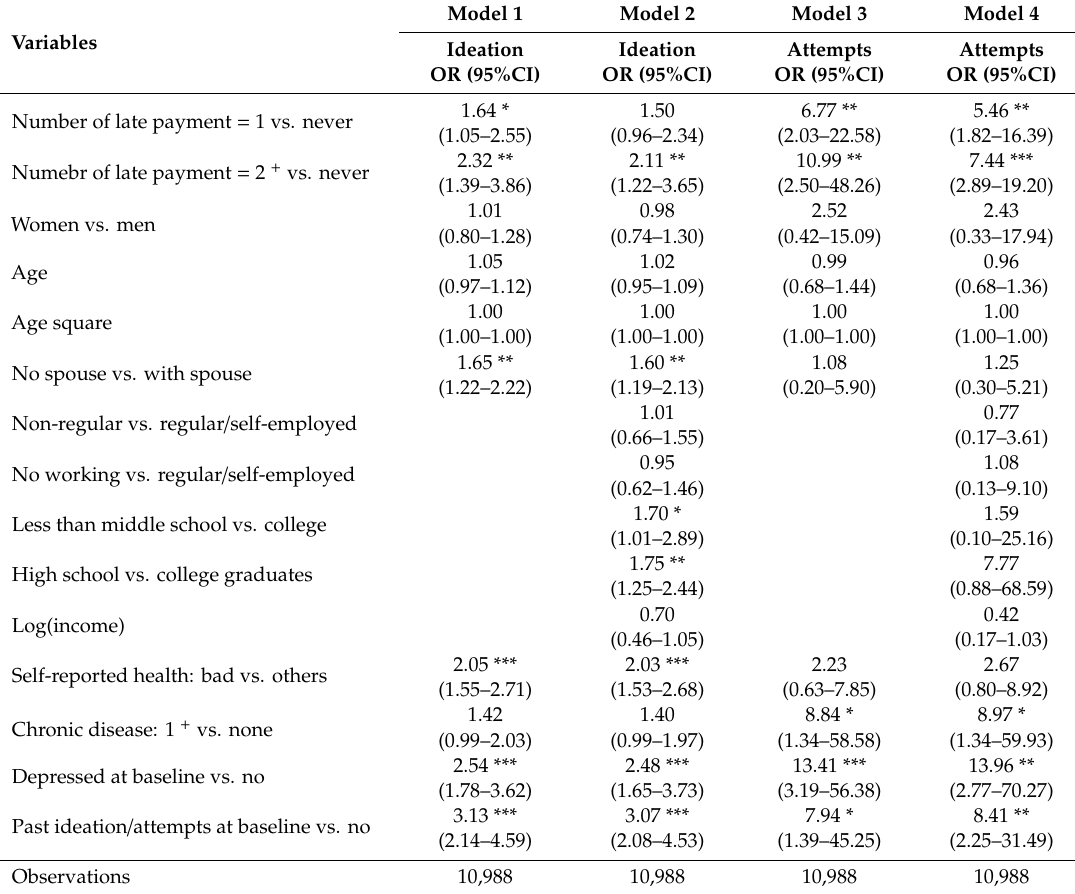
Table 3. Multivariable logistic regression